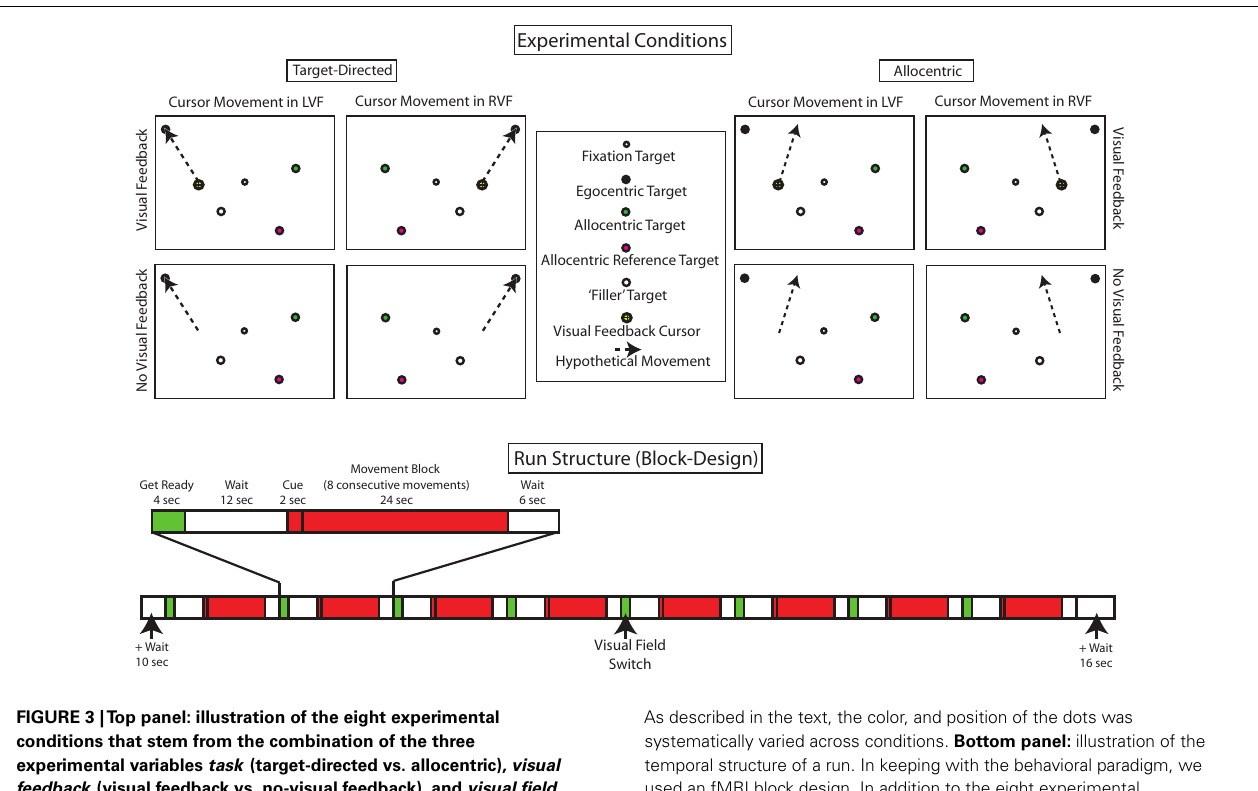
FIGURE 3 |Top panel: illustration of the eight experimental conditions that stem from the combination of the three experimental variables task (target-directed vs. allocentric), visual feedback (visual feedback vs. no-visual feedback), and visual field (left vs. right). For ease of visualization, only one trial is illustrated for each condition, but movements were performed in sequences of eight.